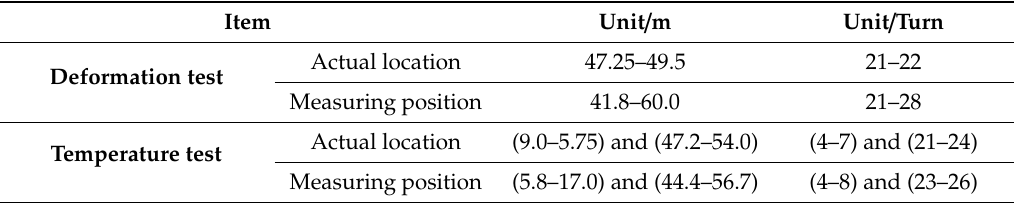
Table 5. Comparison of deformation and heat-up test results.